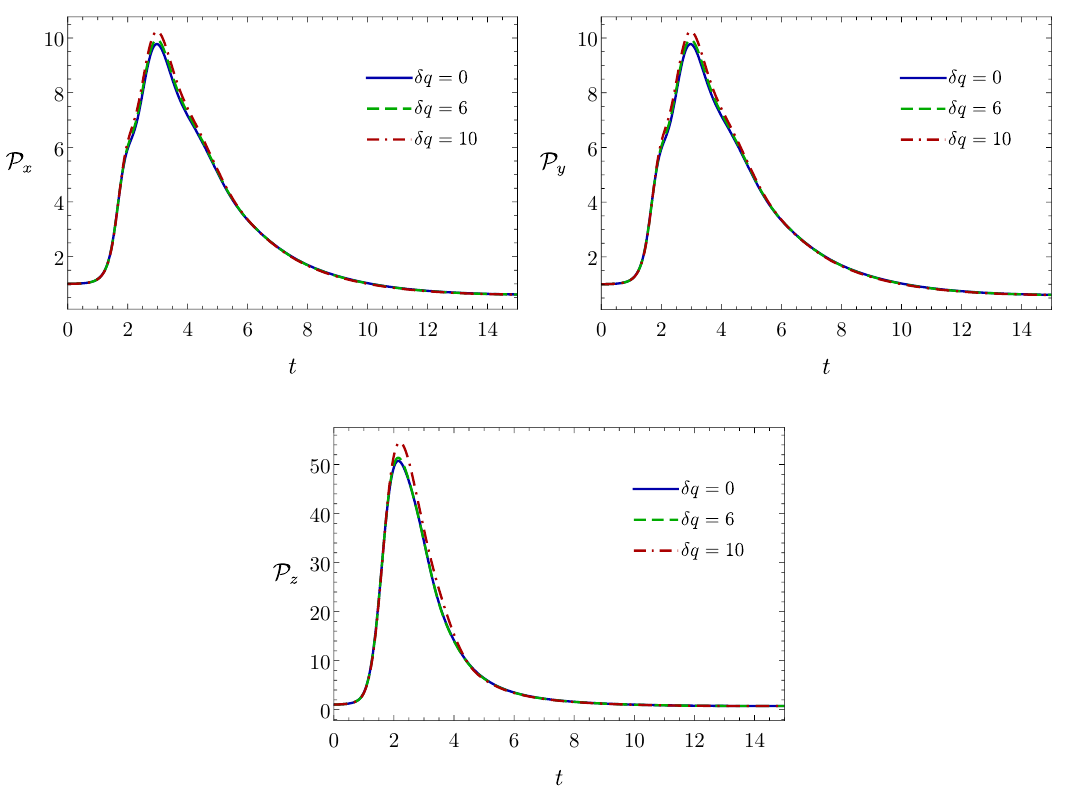
Figure 8 . Pressures along the three active directions ( τ ii ) at the spatial origin for head-on spherical blob collisions from table